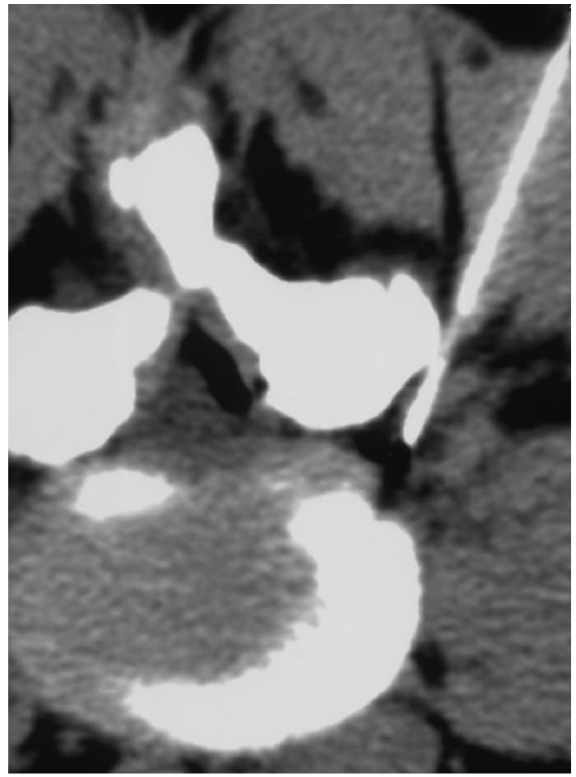
Figure 1. CT scan check of needle positioning before treatment by steroid infiltration.